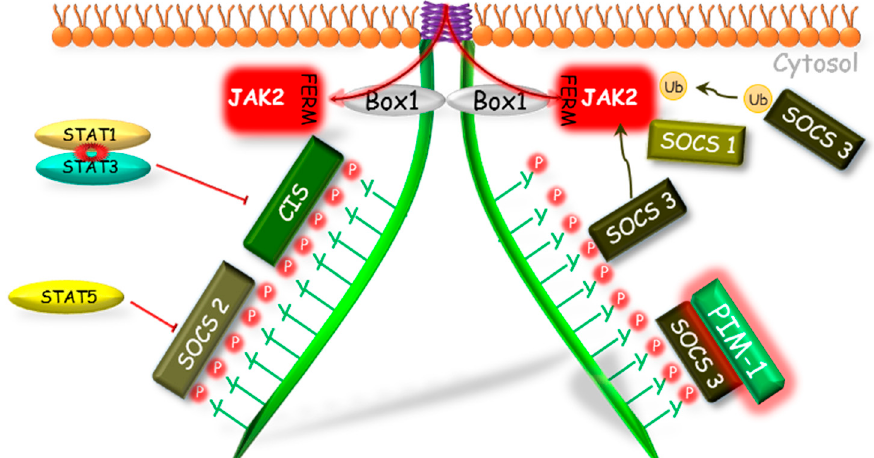
Figure 2. The SOCS proteins mechanisms of GHR-JAK2-STAT pathway inhibition. The SOCS1, 2, 3 and CIS have the same mechanism of phosphorylation inhibition of STAT by competitive binding to phosphotyrosines of the GHR. The SOCS1 and SOCS3, because of the KIR domain presence, can act also in a different manner. Both of them can bind to JAK2; however, SOCS1 can bind directly to JAK2 inhibiting its enzymatic activity and SOCS3 before binding to JAK2 requires binding to GHR, which leads to degradation of the GHR-JAK2 complex directly or indirectly by ubiquitination. Another mechanism of SOCS1 and SOCS3 action is dependent on the PIM-1 protein, which probably stabilizes their phosphorylation and prolongs their inhibitory action. CIS, SOCS—suppressors of cytokine signaling; Box 1—proline-rich domain; GHR—growth hormone receptor; JAK2—Janus kinase 2; FERM—N-terminal 4.1, Ezrin, Radixin, Moesin domain; KIR—kinase inhibitory region; P— phosphorylation marker; PIM-1—proto-oncogene serine/threonine-protein kinase; STAT—signal transducer and activator of transcription; Ub—ubiquitination.